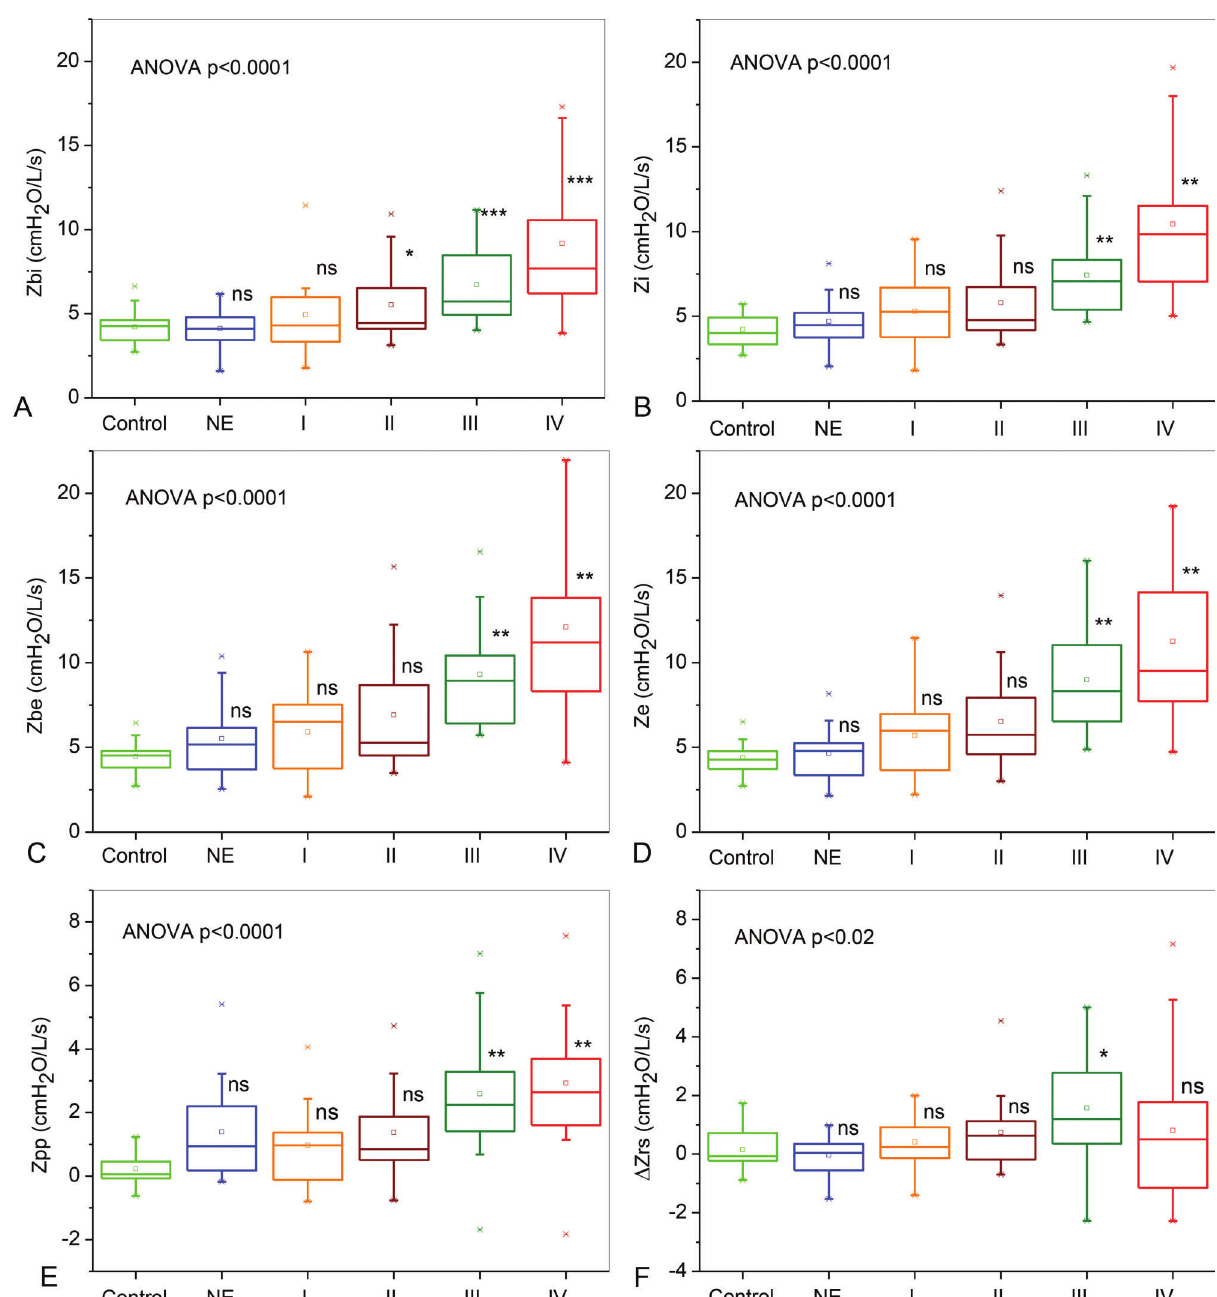
Figure 2 - Comparisons among the mean impedances at the beginning of inspiration (Zbi, A), during the inspiratory phase (Zi, B), at the beginning of expiration (Zbe, C), and during the expiratory phase (Ze, C), in addition to the peak-to-peak impedance (Zpp=Zbe-Zbi; D) and the respiratory cycle dependence ( D Zrs=Ze-Zi; F). The top and bottom of the box plots represent the 25th- and 75th-percentile values, respectively. Additionally, the circles represent the mean values, the bars across the boxes represent the median values, and the whiskers outside the boxes represent the 5th- and 95th-percentile values. Differences relative to the controls: * p o 0.05, ** p o